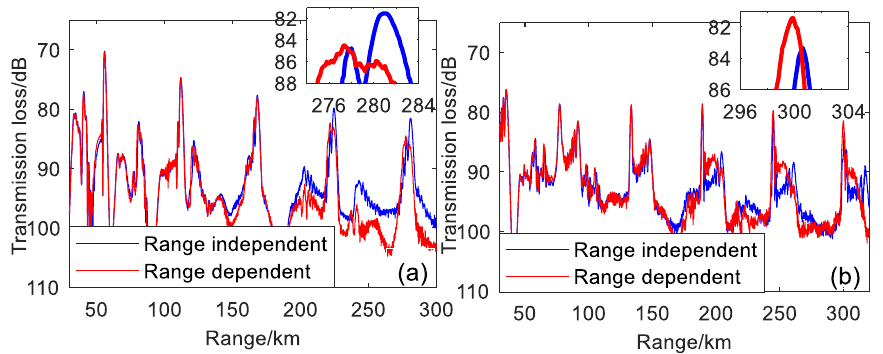
Figure 16. Transmission loss obtained from range-independent and range-dependent sound speed profiles at source depth of 100 m and receiver depths of ( a ) 100 and ( b ) 3800 m.